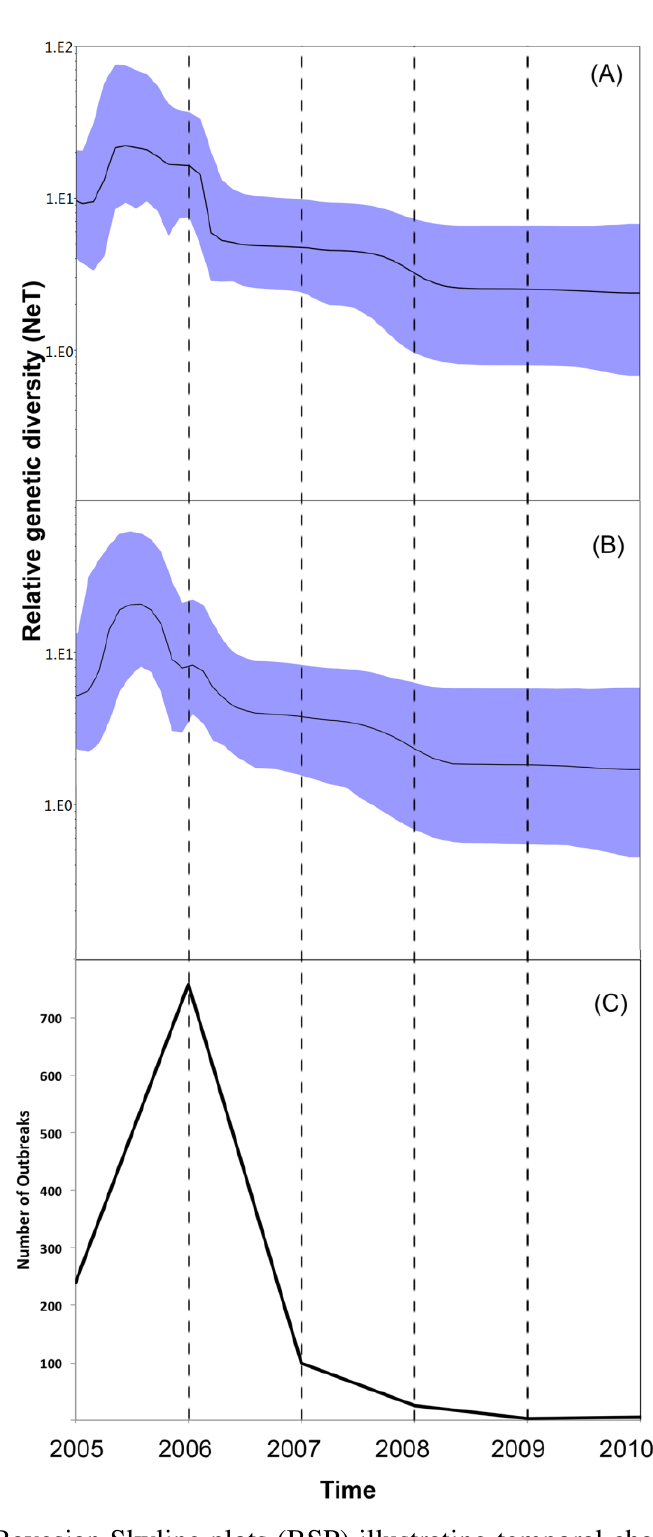
Figure 1. ( A , B ) Bayesian Skyline plots (BSP) illustrating temporal changes in the relative genetic diversity of H5N1 HPAIV isolates from outbreaks in Europe and the Russia between May, 2005 and June, 2010 estimated from the HA and NA gene sequences. Line plots summarize estimates of the effective population size ( N e T ), a measure of genetic diversity, for HA (above) and NA (below) gene regions; the shaded regions correspond to the 95% HPD; ( C ) Temporal distribution of H5N1 HPAI outbreaks (per year) in domesticated poultry and wild birds in Europe and Russia from between 2005 and 2010.